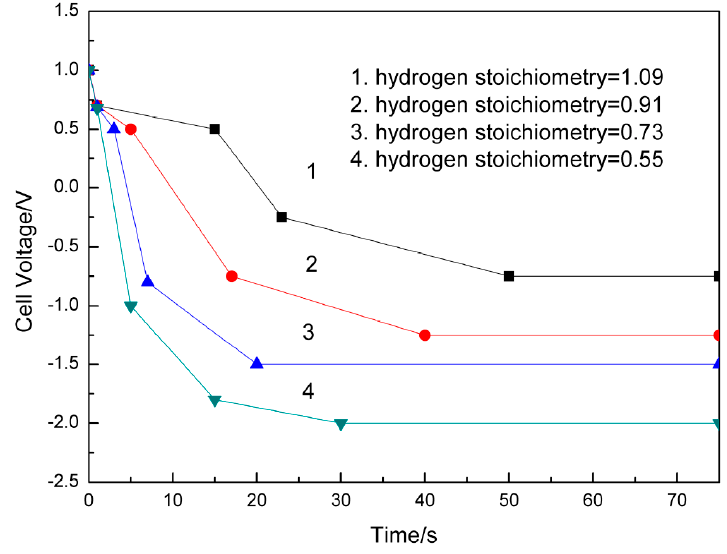
Figure 3. Changes of the anode potentials over time under different hydrogen stoichiometry. From 1 to 4, hydrogen stoichiometry is 1.09, 0.91, 0.73, and 0.55, respectively. Reproduced with permission from [30]. Copyright Elsevier, 2009. Table 1. Different times for cell reversal in different hydrogen stoichiometry.